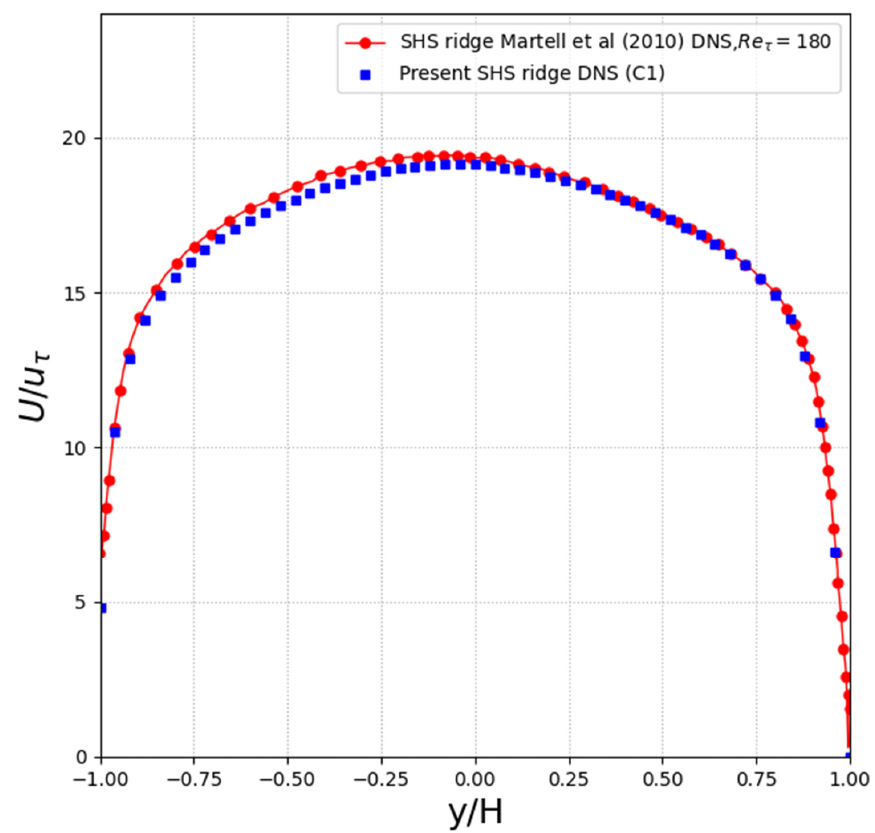
Figure 8. Comparison of the velocity profile between the present results (C1) and Martell et al. [1] for SHS with w/h = g/h = 0.1875.